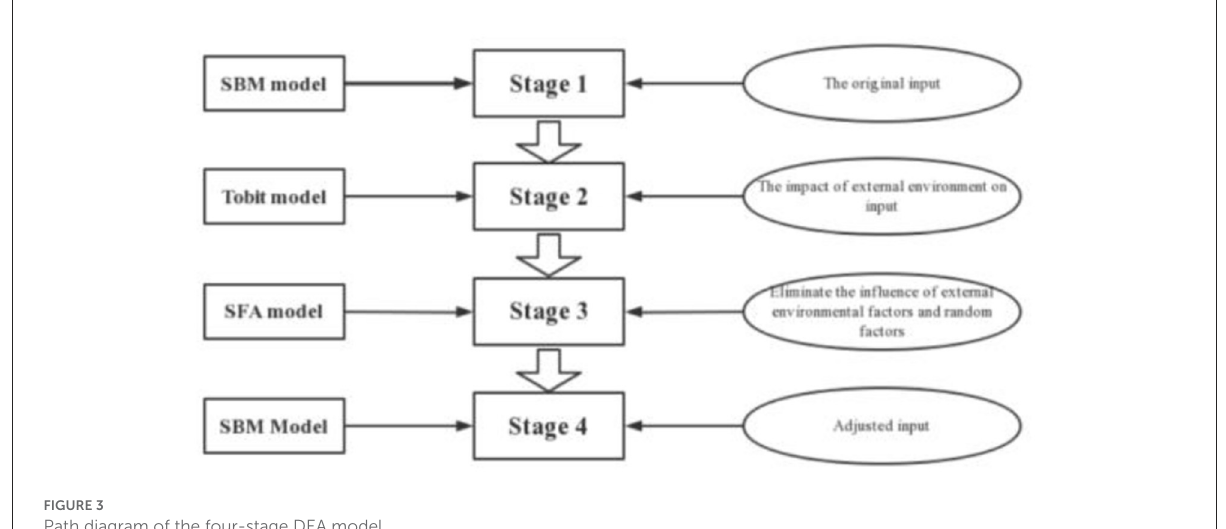
FIGURE3 Path diagram of the four-stage DEA model.